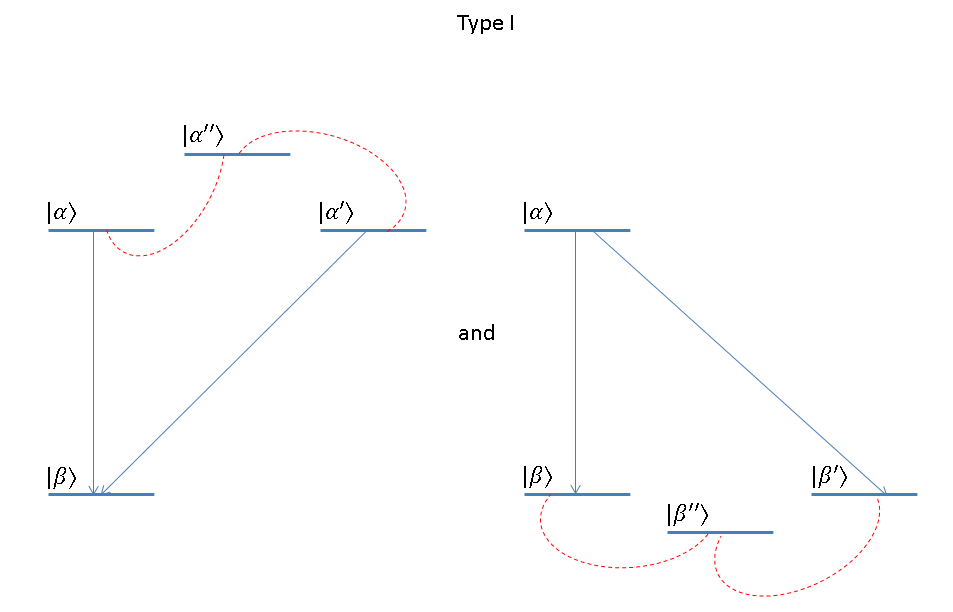
Figure 4. Atomic schemes corresponding to nondiagonal terms of the collision operator (type I).